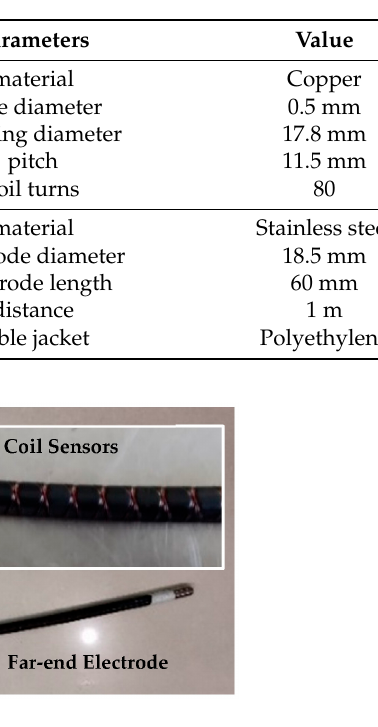
Figure 6. Time domain of experimental section signals from static to vibrations.